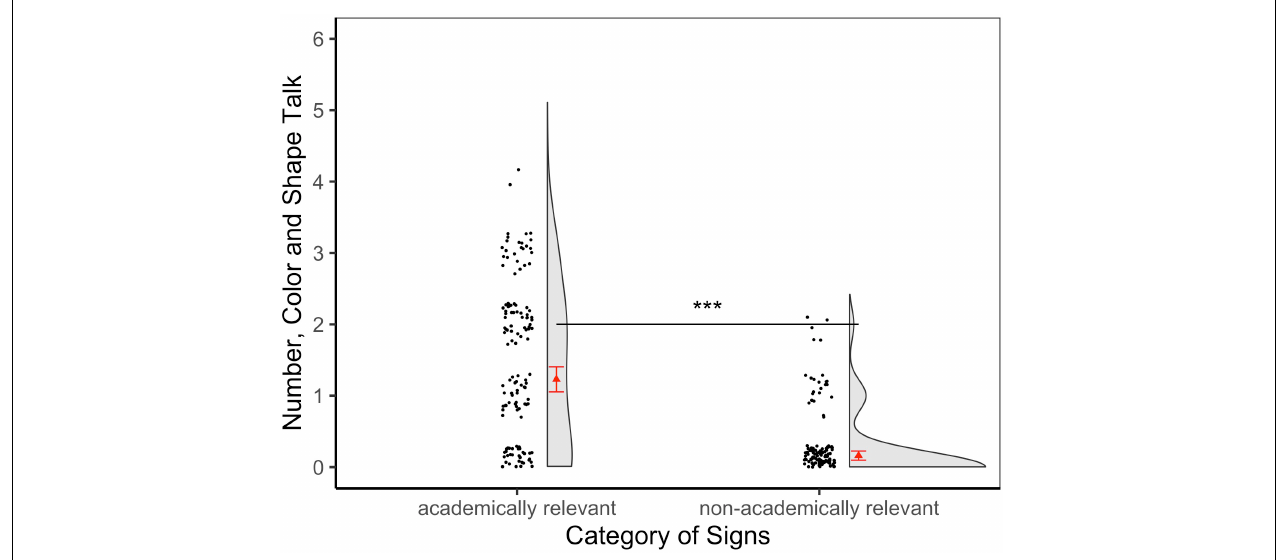
FIGURE 3 | Number, color, and shape talk produced by families across the academically-relevant and non-academically-relevant sign categories. This score ranged from 0 to 6. The red triangle represents the mean and the red whiskers are standard error bars. The black dots represent the individual data points in the distribution and the half-violin plot represents the density of the distribution at different levels of the dependent variable. *** p < 0.001.